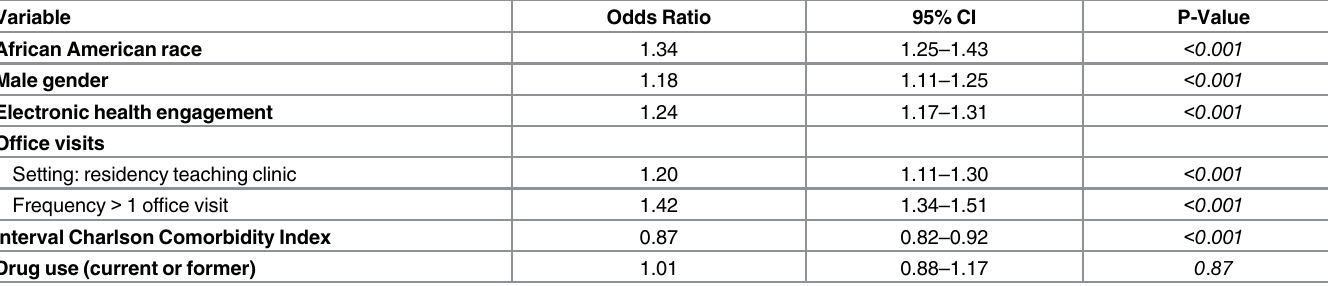
Table 3. Variables associated with hepatitis C virus screening on multivariate analysis.